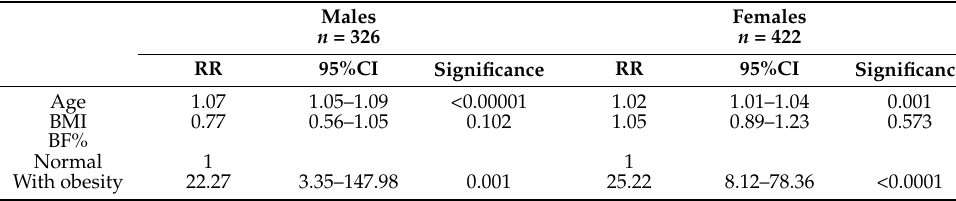
Table 3. Adjusted relative risk for sarcopenia ¥ ( n = 743).